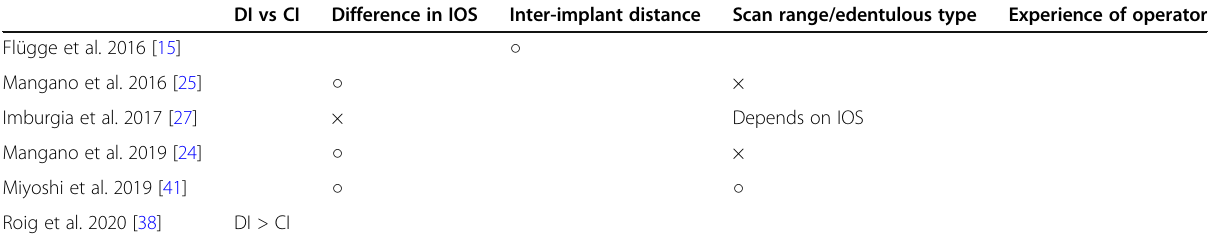
Table 8 Summary of the comparison of DI and CI, and each parameters ’ effect regarding precision of DI DI vs